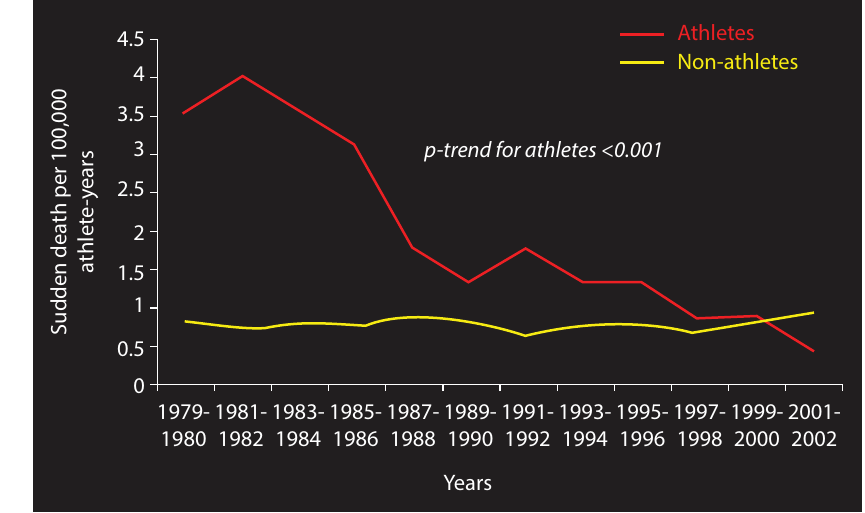
Figure 3. Annual incidence rates of SCD per 100,000 person-years among screened competitive athletes and unscreened non-athletes aged 12 to 35 in the Veneto region, Italy. Note the sharp decline of the screened athlete line in red [28].